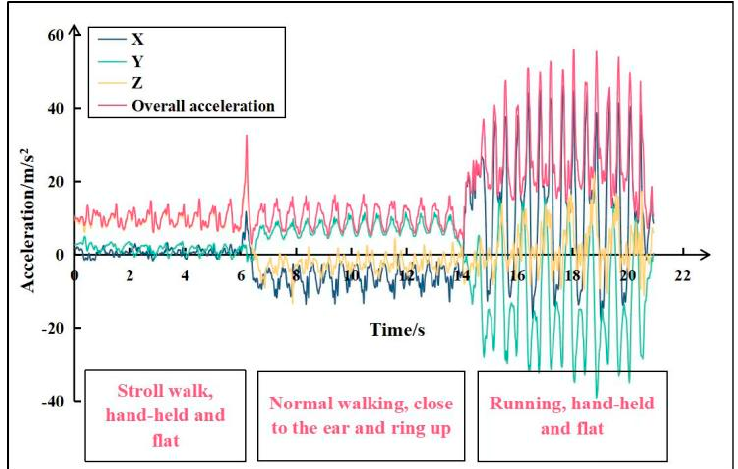
Figure 1. Triaxial acceleration and overall acceleration when walking at will.